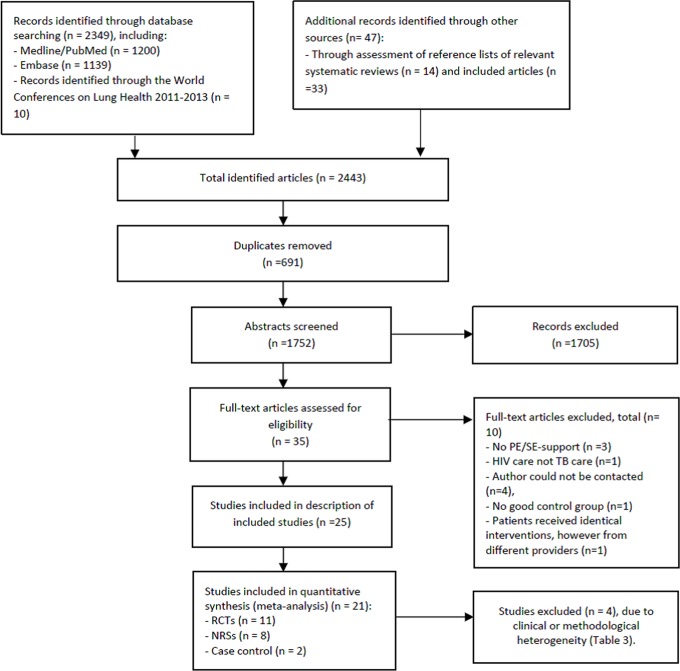
Flow diagram for review and meta-analysis.